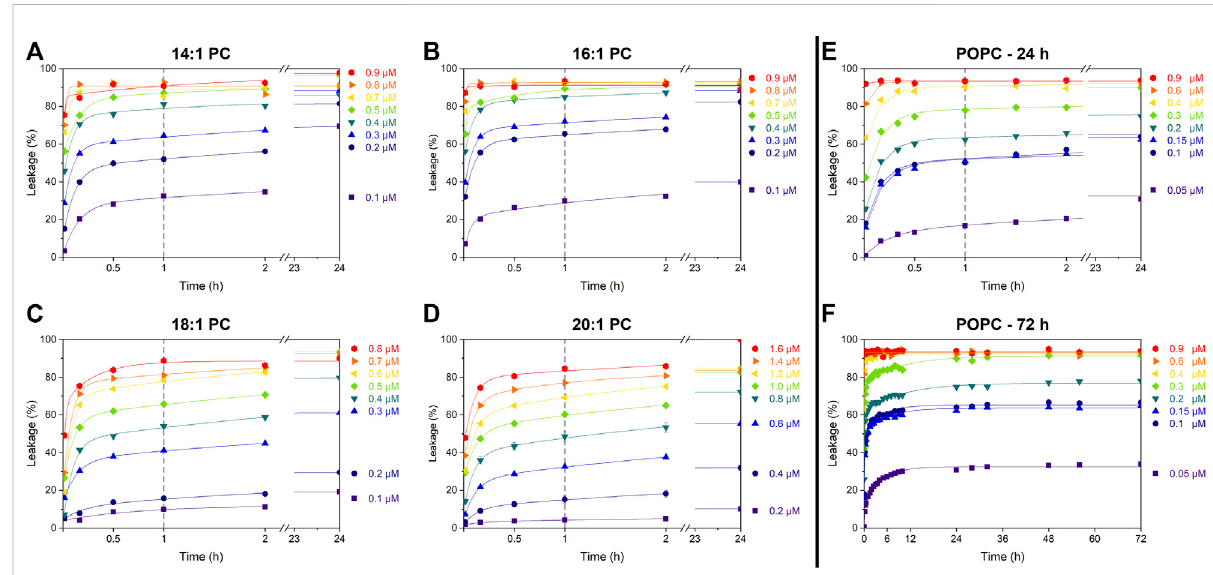
FIGURE 2 Cumulative leakage kinetics of 14:1 PC (A) , 16:1 PC (B) , 18:1 PC (C) , 20:1 PC (D) , and POPC (E and F) at 30 µM lipid concentration. Data points depictcalceinleakage(%)asafunctionoftimefordifferenttolaasinconcentrationsasindicatednexttoeachplot.Linesaretoguidetheeyeonly.The vertical gray dashed line after 1 h represents the standard incubation time; the fast leakage component appears to be essentially completed by this